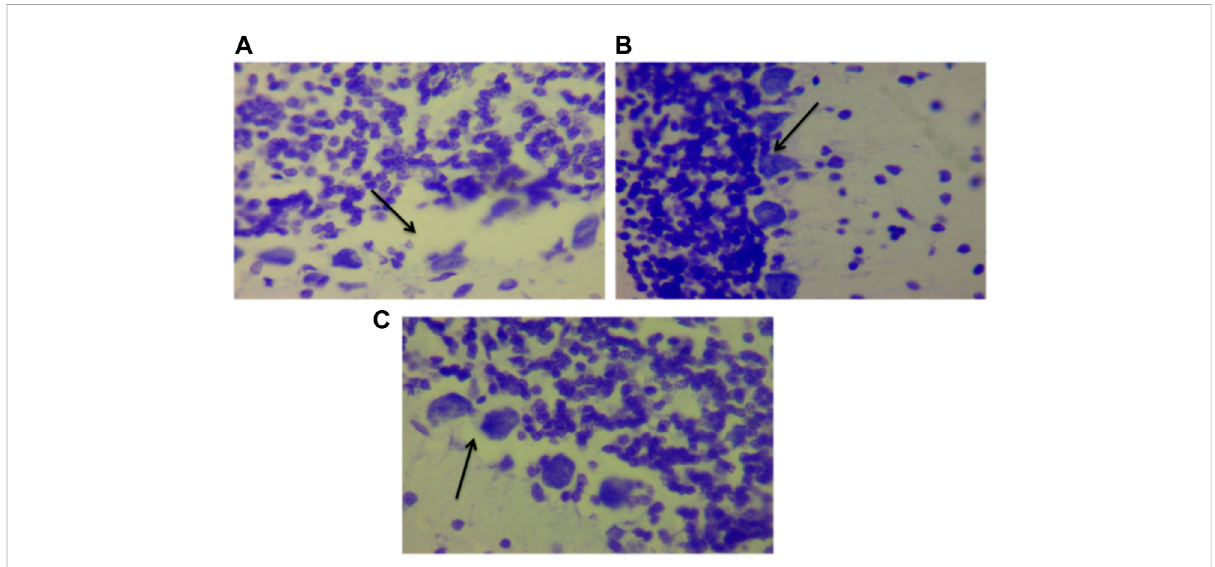
FIGURE 15 Photomicrograph of the cerebellum of (A) Traumatized non-treated (Group II) group showing loss of Purkinje cells (arrows), (B) Non traumatized non treated (Group III) rats showing a normal architecture of the cerebellum, and (C) DMSO treated rats (Group I) showing restored cell layer, DMSO dimethylsulfoxide, Nissl stain, X40.